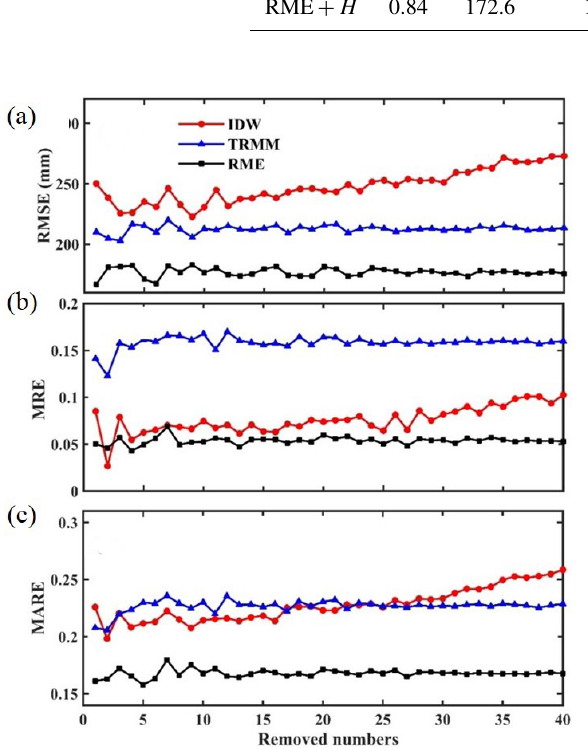
Figure 11. Performance of E RMS , E MR , and E MAR for three meth- ods in different removed